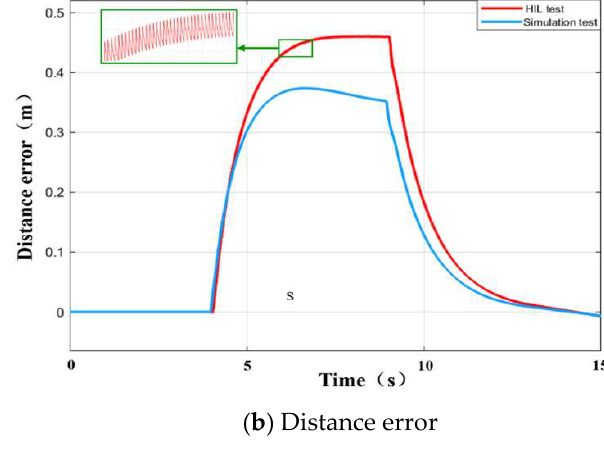
comparison of distance error and heading error between different simulation test and